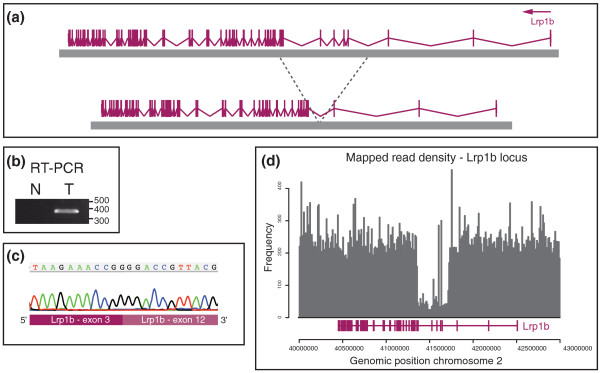
The internally rearranged gene Lrp1b/LRP1b. (a) Schematic representation of the Lrp1b internal deletion in PD3682a. (b) RT-PCR product of RNA between exon 3 and exon 12 of Lrp1b. (c) Sequence trace of the RT-PCR product confirms the fusion between exon 3 and 12. (d) Read coverage density confirms the deletion of exons 4 to 11.